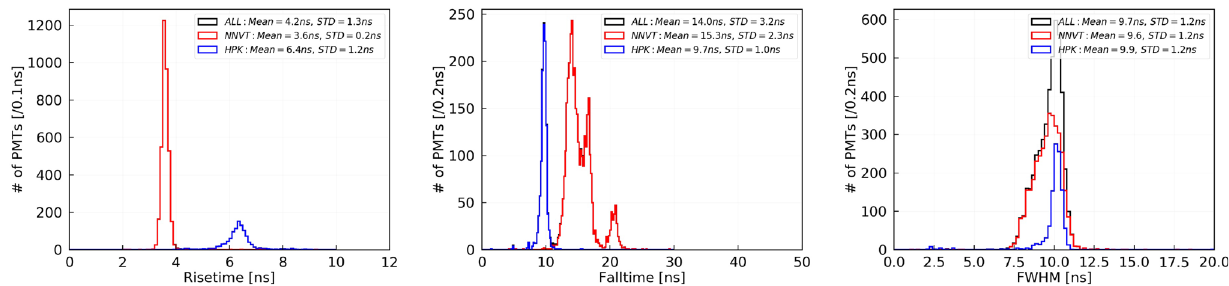
Fig. 47 Measured rise-time (left), fall-time (middle) and FWHM (right) of potted PMTs at a gain of 1 × 10 7 from containers #A and #B. Black: all PMTs; blue: HPK; red: NNVT